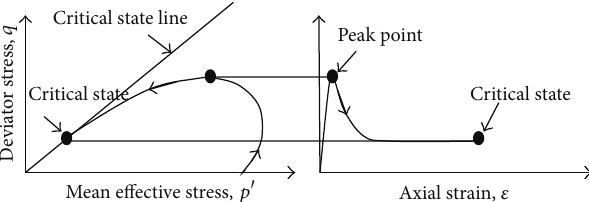
Figure 1: Idealised behaviour of loose particular soil in undrained triaxial shear